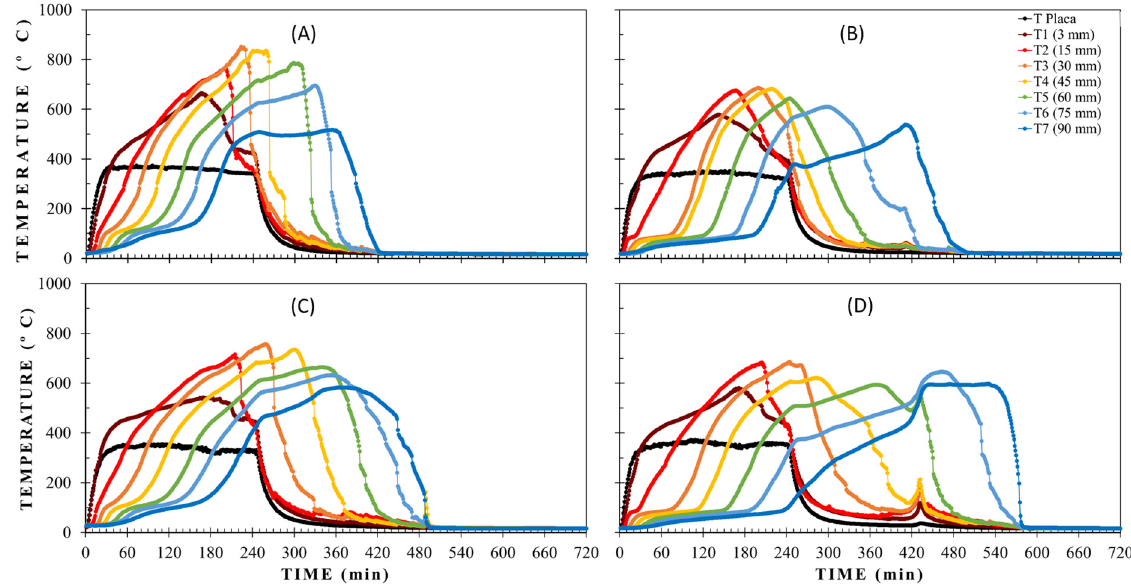
Figure 5. Temperature evolution of CF-Dried ( A ), CF-Wet ( B ), CF-Dried-V ( C ), and CF-Wet-V ( D ).